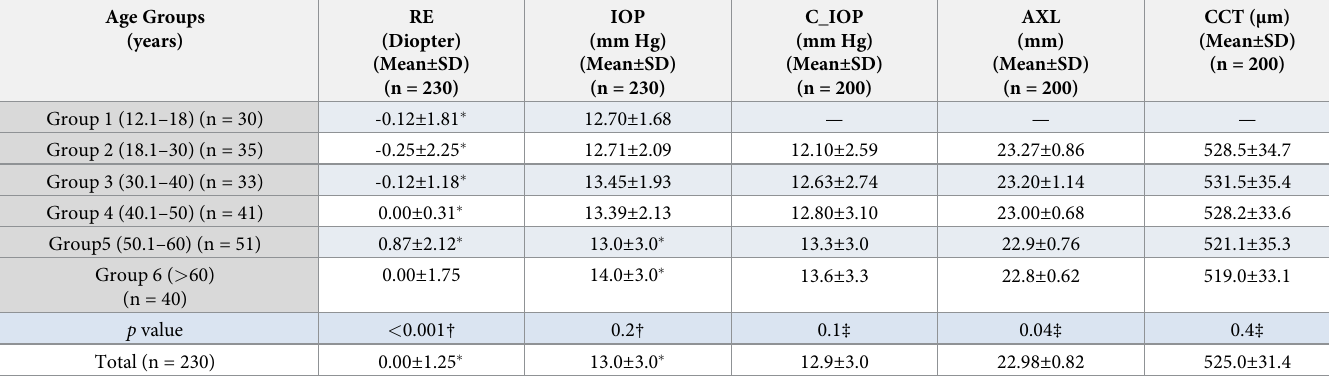
Table 1. Choroidal thickness in normal Indian subjects using SS-OCT: Details of ocular parameters in different age groups.